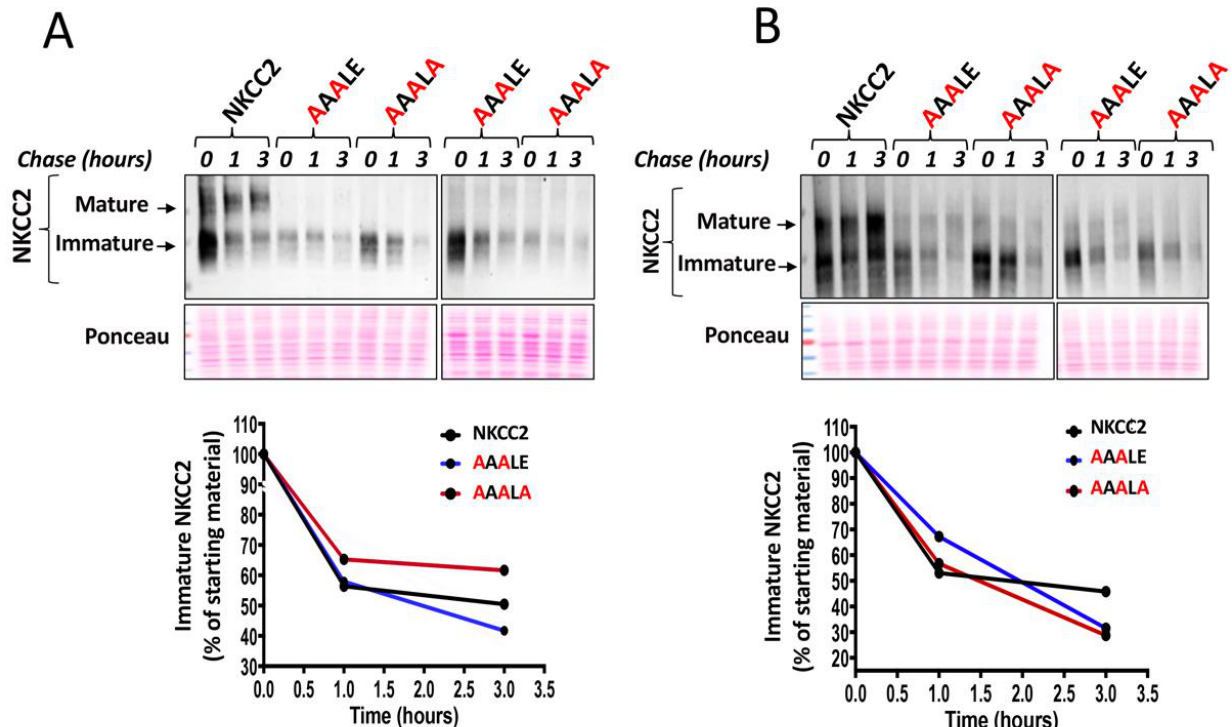
Figure 5. Mutation of the 1019 DAELE 1023 signal impairs NKCC2 maturation. ( A , B ), cycloheximide chase analysis of wild-type and mutated NKCC2 proteins. 14–16 h post-transfection, OKP cells ( A ) or HEK cells ( B ) transiently expressing WT NKCC2 or mutant proteins. 1019 AAALE 1023 or 1019 AAALA 1023 , were chased for the indicated time after addition of cycloheximide. Total cell lysates were separated by SDS-PAGE and probed by anti-Myc antibodies. Lower panels , Quantitative analysis of the immature NKCC2 protein abundance. The density of the immature form of NKCC2 proteins was normalized to the density at time 0. Each point represents mean from two independent experiments.